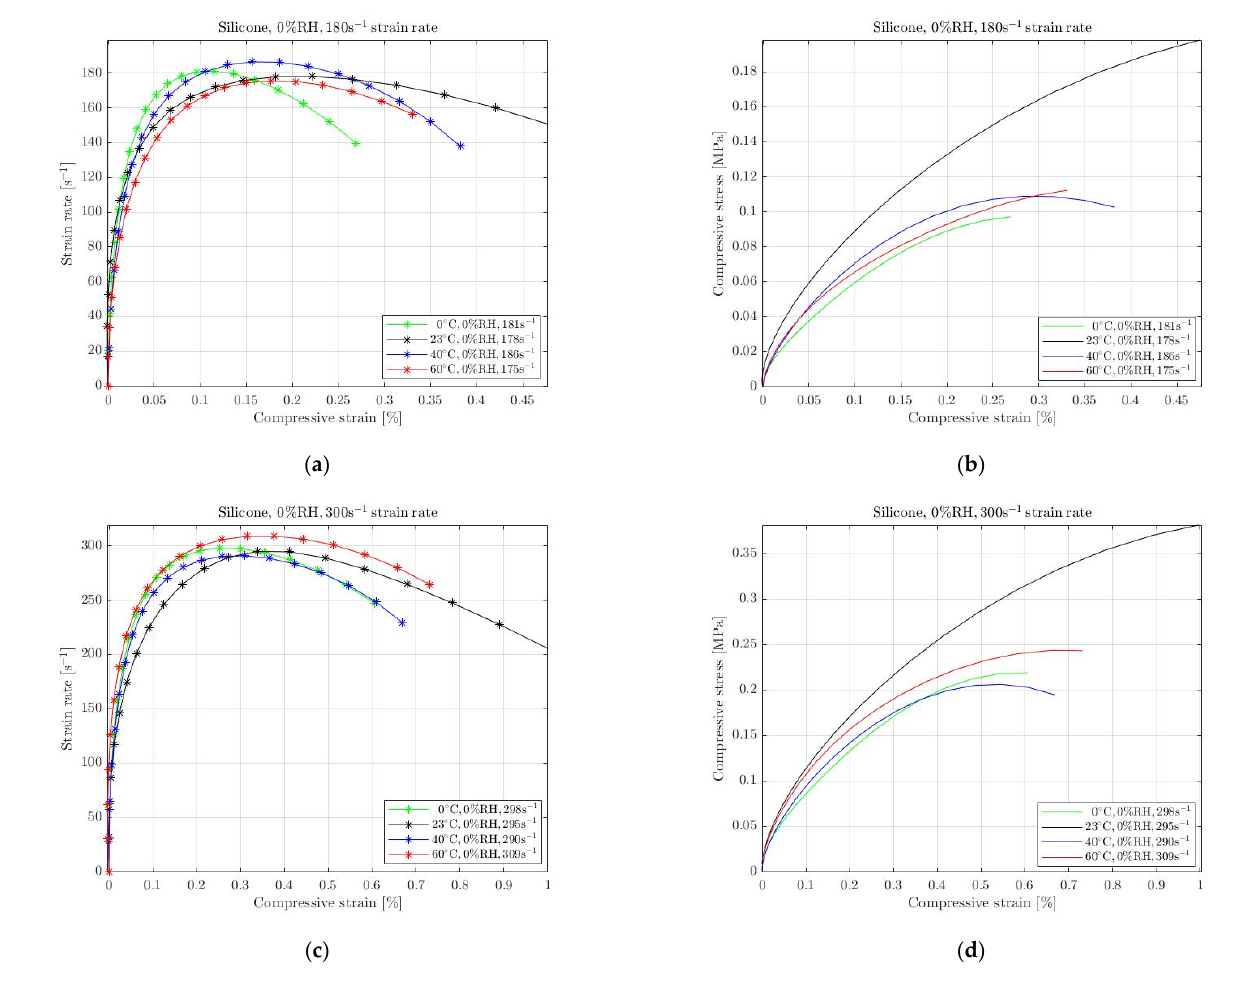
Figure 6. Strain rate vs. compressive strain ( a , c ) and compressive stress vs. compressive strain ( b , d ) of silicone at 0 °C, 23 °C, 40 °C and 60 °C temperature with 0% RH for approximately 180 s − 1 ( a , b ) and 300 s − 1 ( c , d ) strain rate.